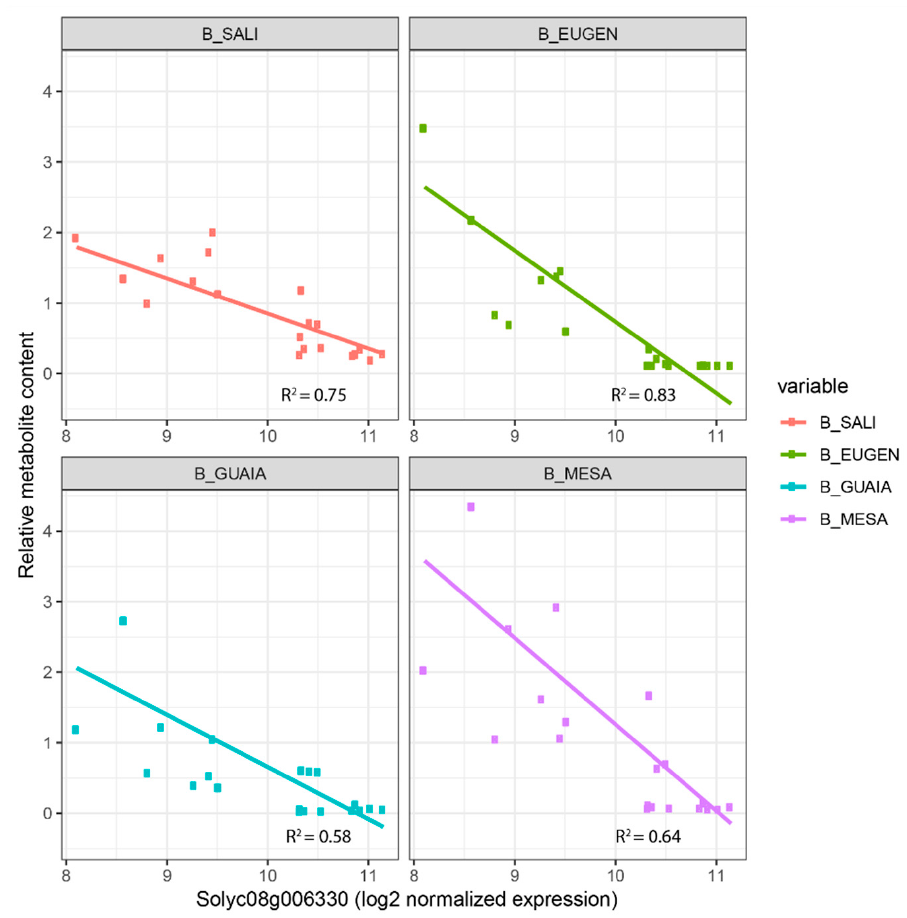
Figure 4. Benzenoid VOC contents according to the candidate gene Solyc08g006330 expression. We calculated coefficients of determination for each linear regression. ‘MESA’: methyl salicylate; ‘SALI’: salicylaldehyde; ‘GUAIA’: guaiacol; ‘EUGEN’: eugenol).